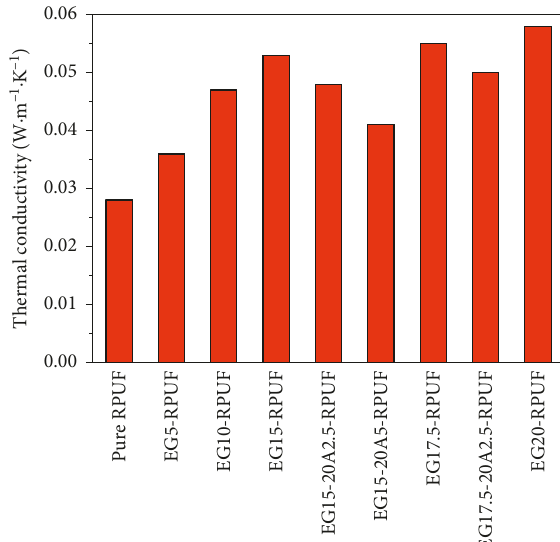
Figure 7: Thermal conductivity of pure RPUF and RPUF